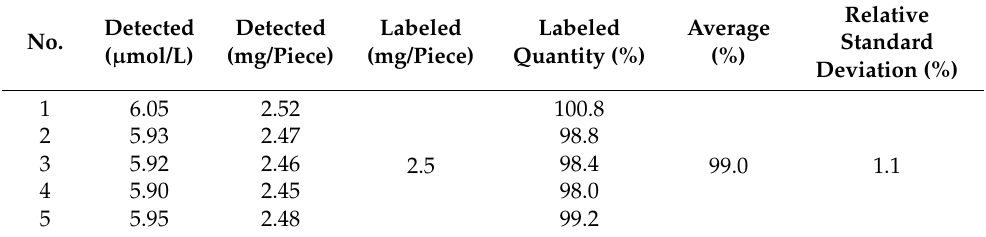
Table 2. Determination of MTX concentration in medicine ( n = 5).